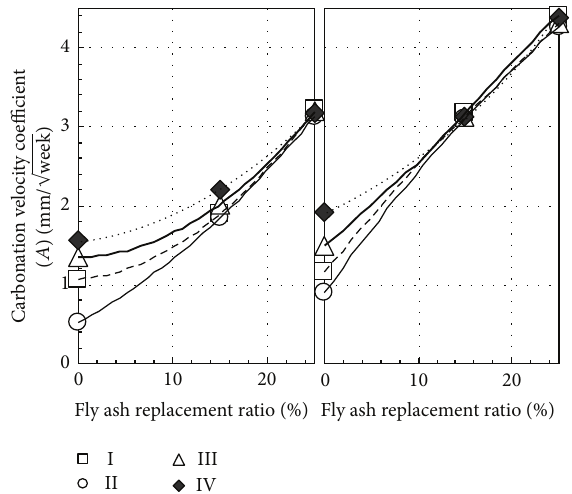
Figure 10: Relationship between fly ash replacement ratio of different precuring pattern and carbonation velocity coefficient.